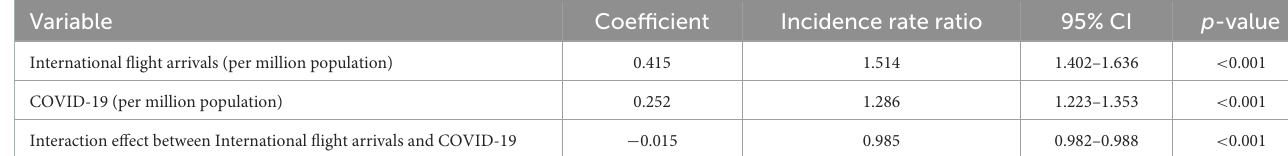
TABLE 2 Negative binomial regression analysis of association between number of MPX cases and key risk factors of MPX.